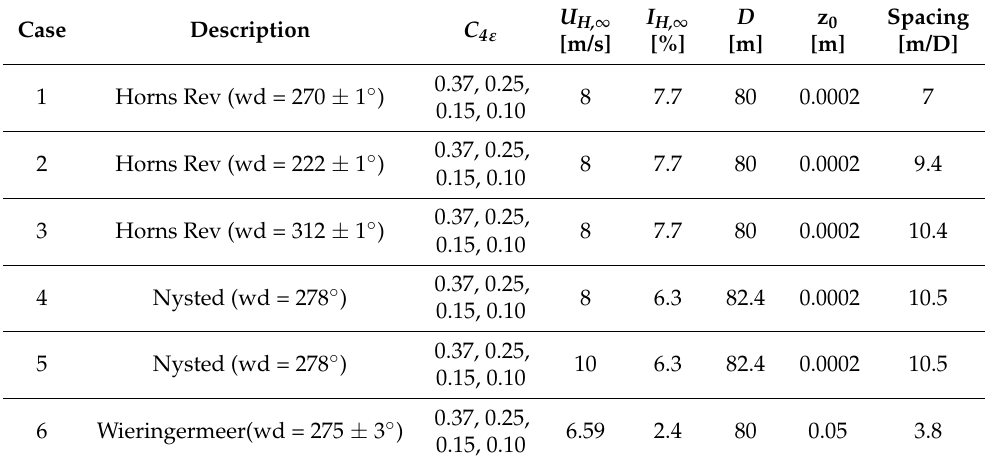
Table 5. Six case settings considering different parameter C 4 ε values.